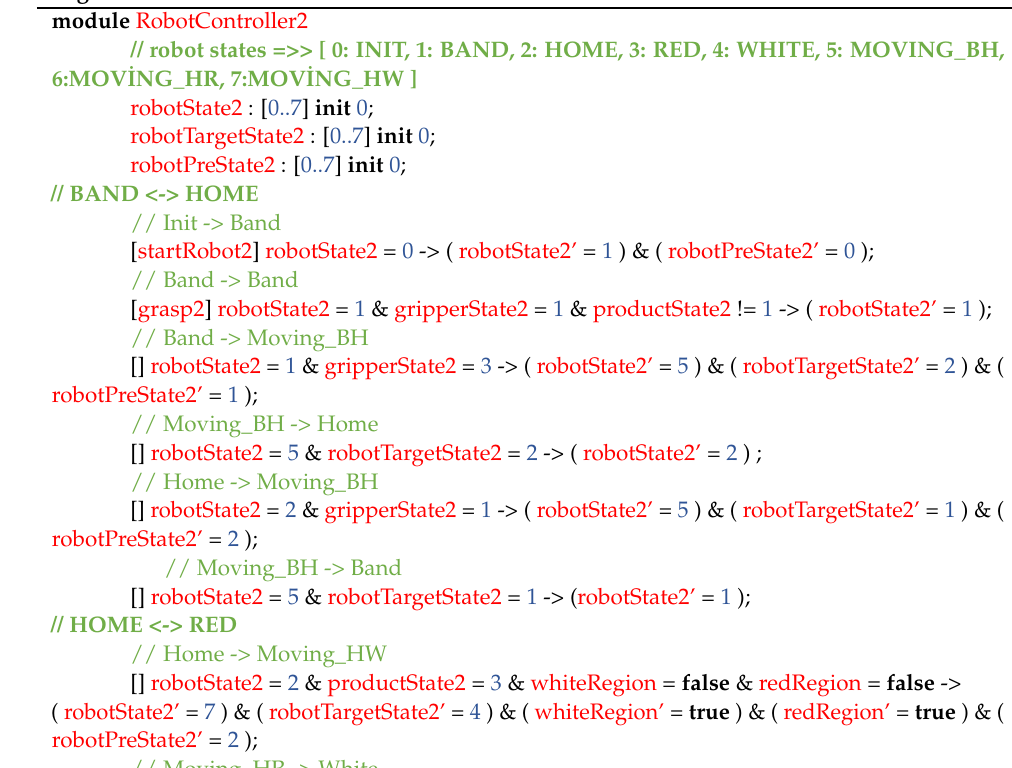
Algorithm 2. PRISM CTMC model of robot controller2. module